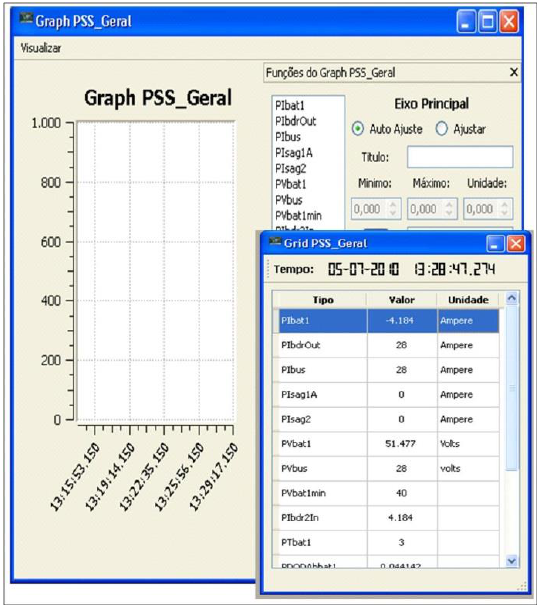
Fig. 5. Visual simulation outputs of a Satellite Power Subsystem shown as graphs and